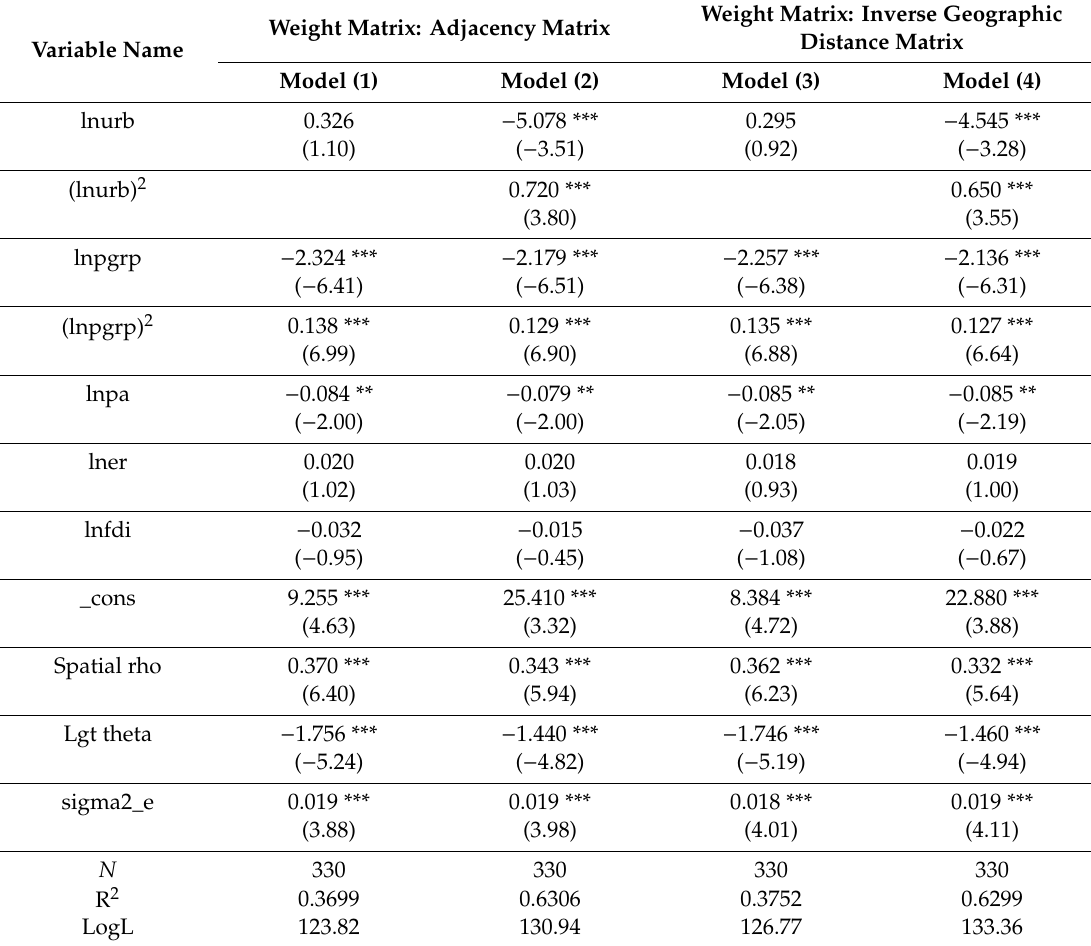
Table 3. Estimated results of the Durbin